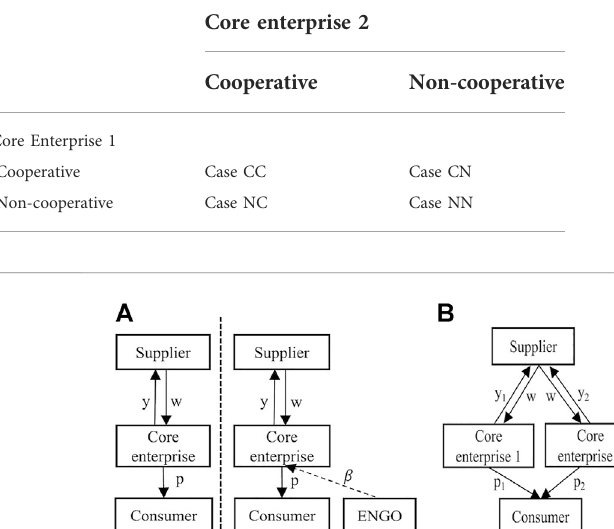
TABLE 3 Matrix incorporating the game between the two core enterprises.